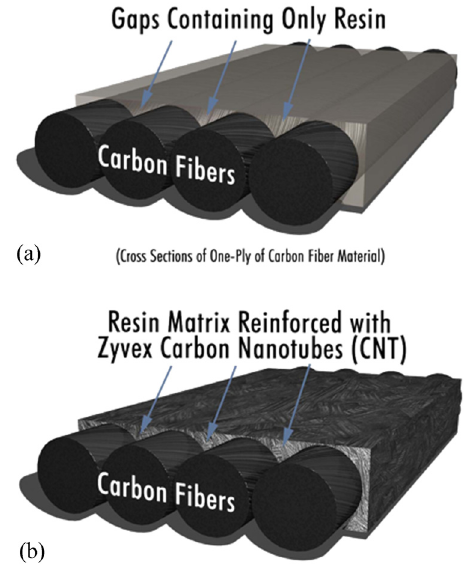
Figure 4: Schematic diagram of prepreg from Zyvex Company cre - ates “ bridges ” between CNT and resin systems. ( a ) Normal carbon fi ber prepreg and ( b ) carbon fi ber prepreg with CNTs added in the